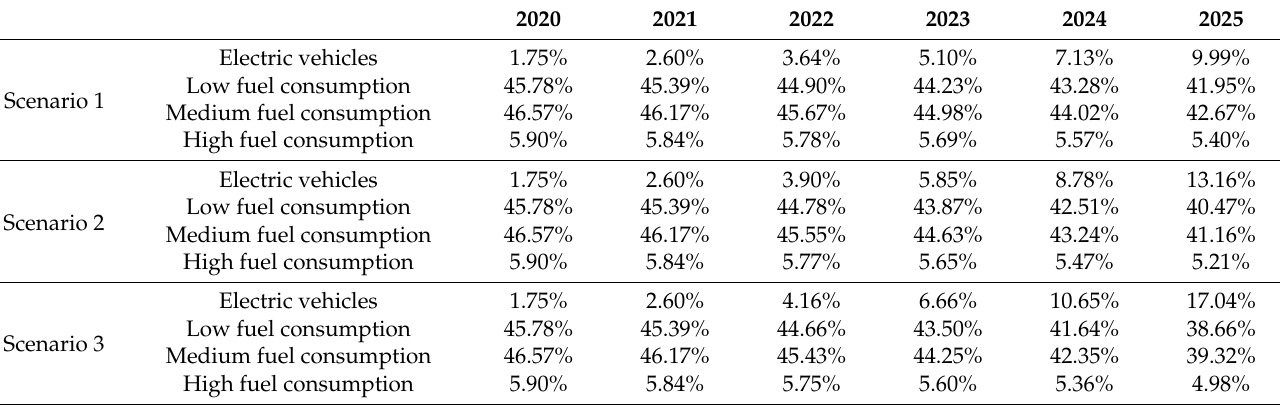
Table 4. Share of different types of vehicles.